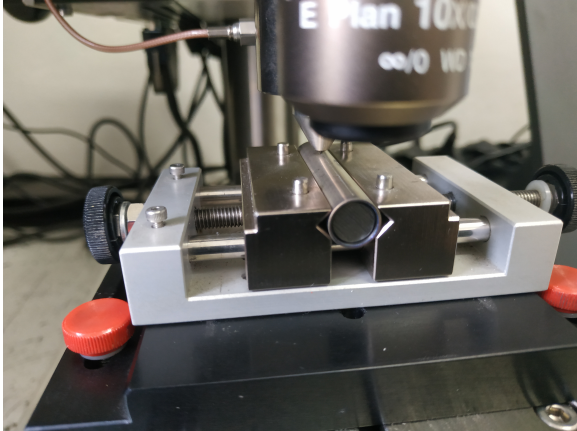
Figure 2. Process of creating scratches.